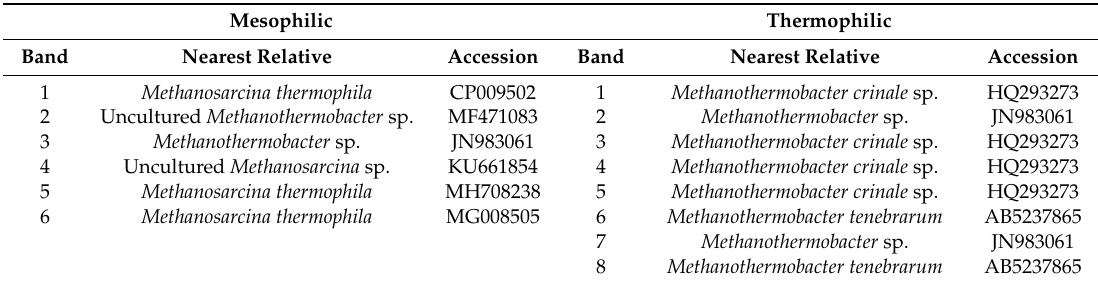
Table 2. Classification of bacterial community taxa in methane producing communities at mesophilic and thermophilic